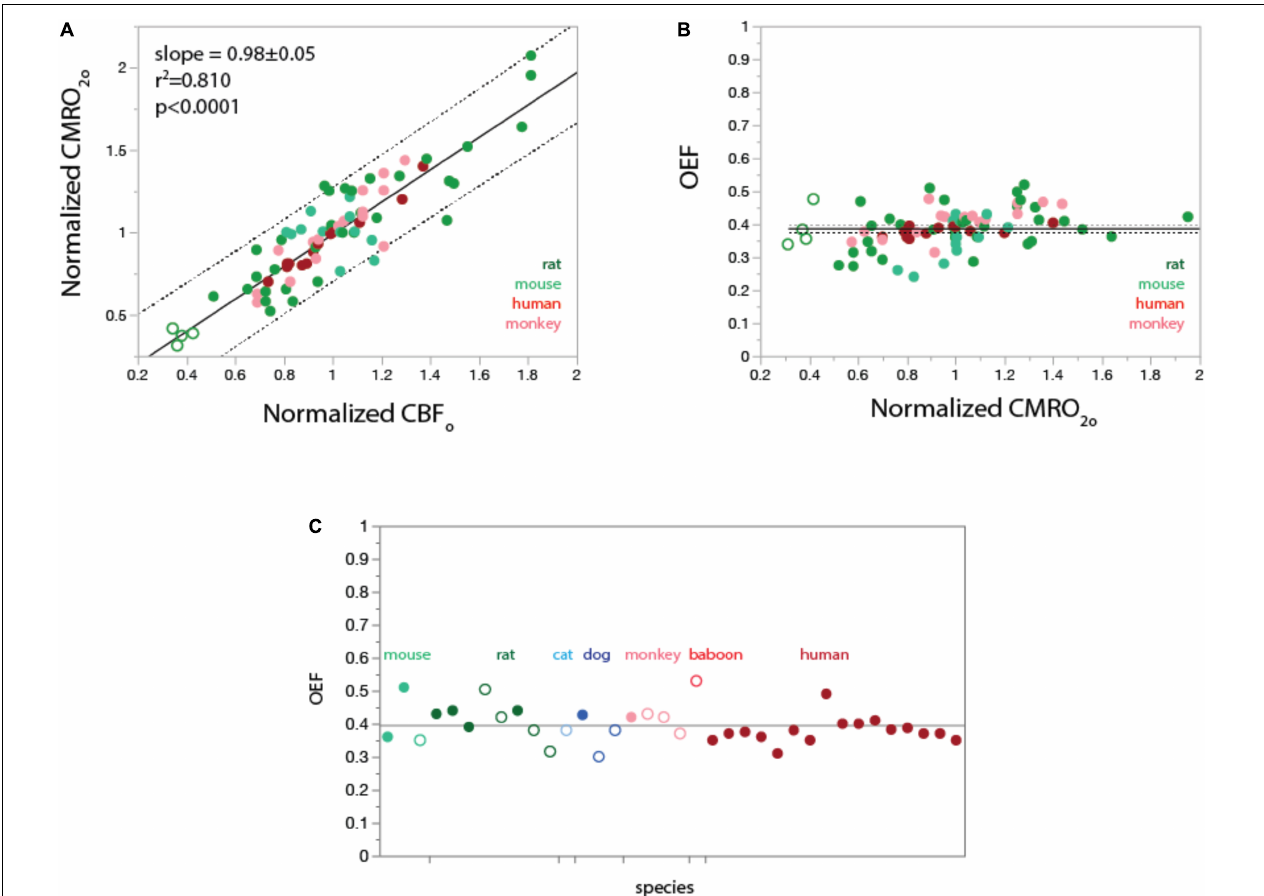
FIGURE 2 | In the undisturbed awake state, rCMRO 2 varies linearly with rCBF both within and across species (A) ; as a consequence, regional OEF o is constant at about 0.4 through different values of rCMRO 2 (B) and across mammalian species (C) . (A,B) data from Frietch et al., 2000 (rat), Raichle et al., 2001 (human), Noda et al., 2002 (rhesus monkey), and Zhu et al., 2013 (mouse). Filled symbols indicate gray matter sites; unfilled symbols indicate white matter. Plotting of values normalized to the average for each species shows that regional CMRO 2 varies linearly (fitted curve, linear function) with regional CBF both within the brain of each species and across species. (B) , Values of OEF o calculated from data in (A) as the ratio of regional capillary oxygen diffusivity (rCMRO 2 ) to regional CBF in the undisturbed awake state (rCBF o ), given a constant PO 2A . Values of OEF o are constant around 0.4 within and across species, as predicted from the linear universal relationship between rCMRO 2 and rCBF o in (A) . Grand mean ± SD: 0.38 ± 0.06 (plotted). Species means ± SD: rat, 0.39 ± 0.06; mouse, 0.35 ± 0.06; rhesus monkey, 0.41 ± 0.05; human, 0.38 ± 0.02. (C) , Values of OEF o reported in the literature for a total of seven mammalian species are also centered around a grand mean of 0.40 ± 0.05 (plotted). Filled symbols indicate awake animals; unfilled symbols indicate anesthesia. Data in C are from Kety (1956); Cohen et al. (1967); Vernheit et al. (1978); Laux and Raichle (1978); Raichle et al. (2001); Oshima et al. (2002); Kaisti et al. (2003); He et al. (2008); Ibaraki et al. (2008); Jain et al. (2010); Qin et al. (2011); Lu et al. (2012); Xu et al. (2012) (human); Hyder et al. (2016); Lee et al. (2017); Laux and Raichle (1978); Altman et al. (1991) (rhesus); Young et al. (1996), Noda et al. (2002) (baboon); Chen et al. (1984); Chang et al. (2016) (dog); Hossman et al. (1976) (cat); Johansson and Siesjo (1975); Nordstrom